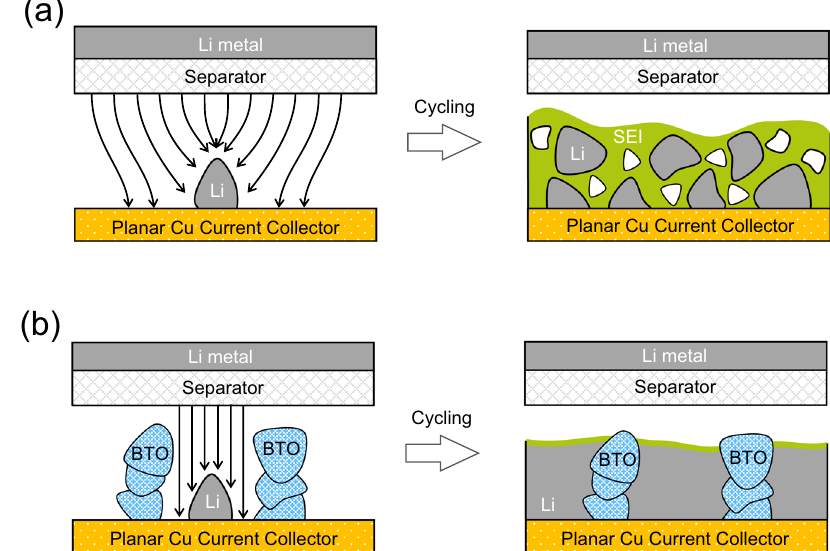
Fig. 8 Schematic diagram of lithium metal plating and stripping with and without the presence of the high dielectric BTO porous scaffold. a Lithium metal plating/stripping process on planer copper, b lithium metal plating/stripping process on BTO-coated copper